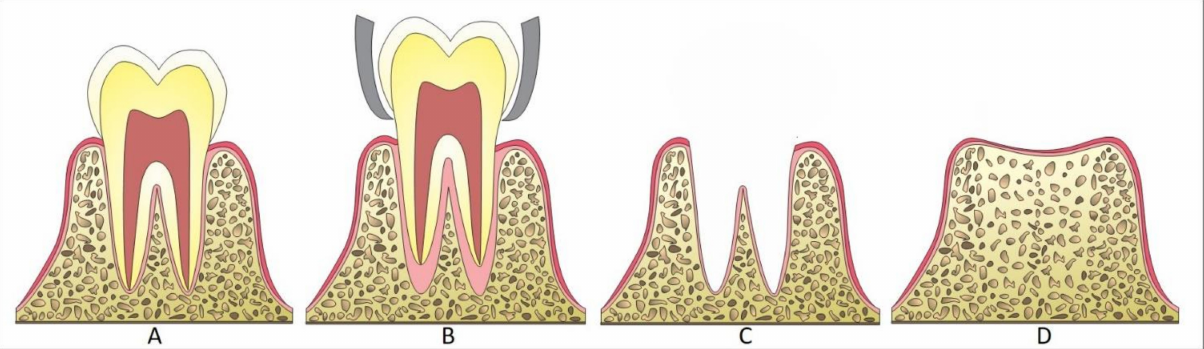
Figure 2. Diagram showing the change in the volume of the alveolar bone ridge resulting from the atraumatic tooth extraction. ( A ) Proper dental implantation. ( B ) Dental extraction with no fracture of the alveolar bone wall. ( C ) Bone condition after tooth extraction. ( D ) Alveolar bone healing.